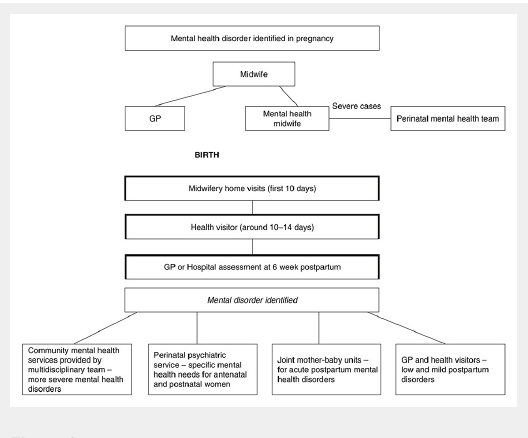
Care pathways offered to perinatal women with mental disorders in the